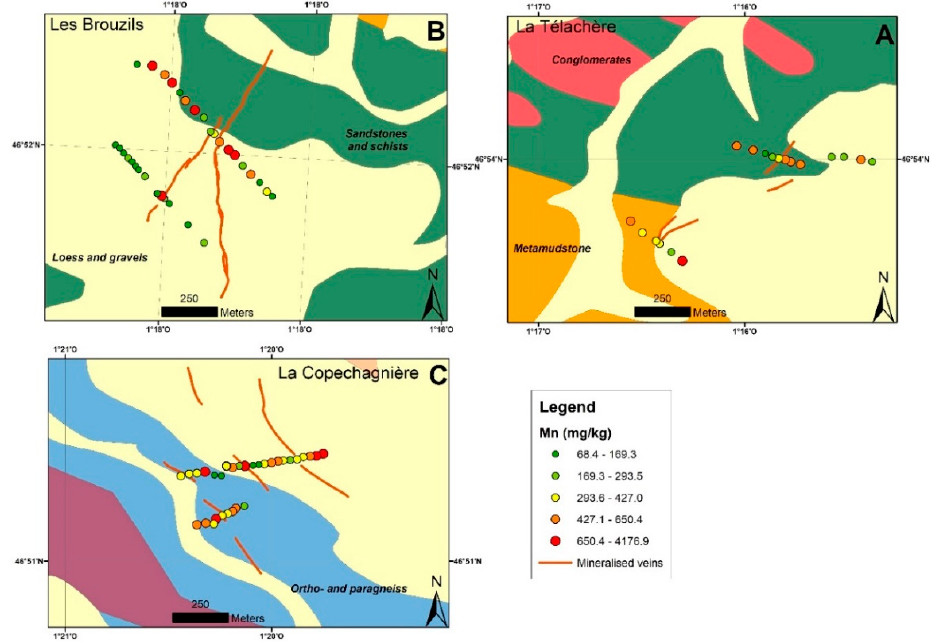
Figure 17. Mn map of B horizon samples (pXRF measurements in mg/kg). ( A ): La Télachère; ( B ): Les Brouzils; ( C ): La Copechagnière.